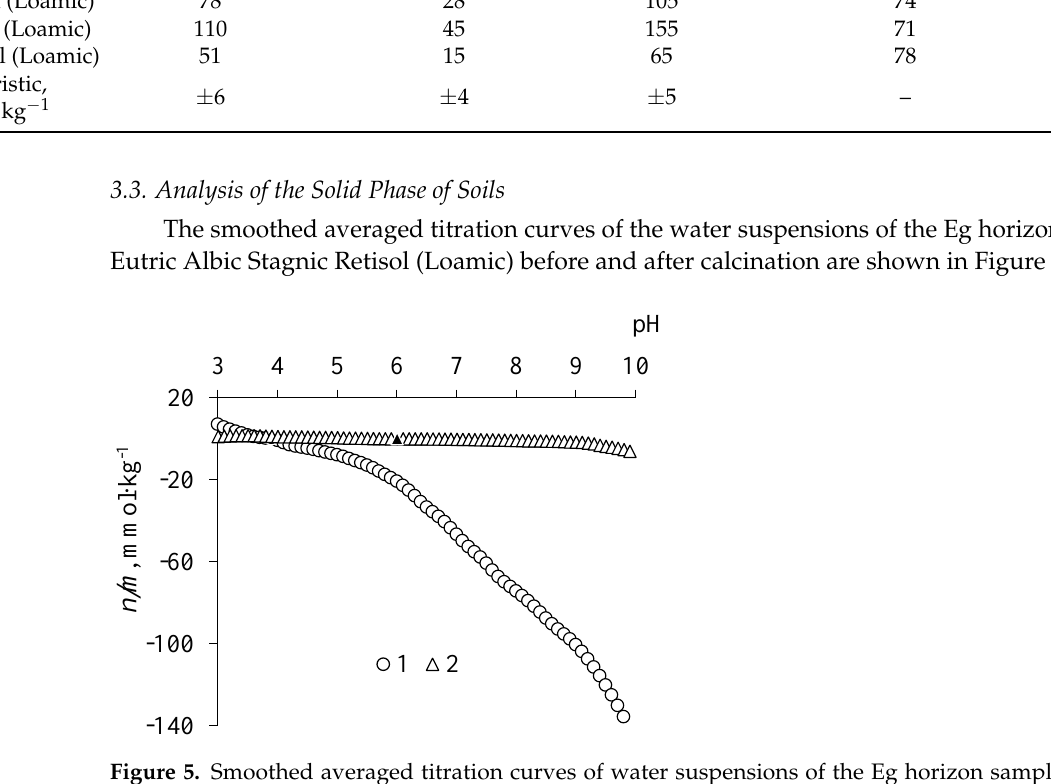
Groups That Passed into the Water Extract, x , %In Extract